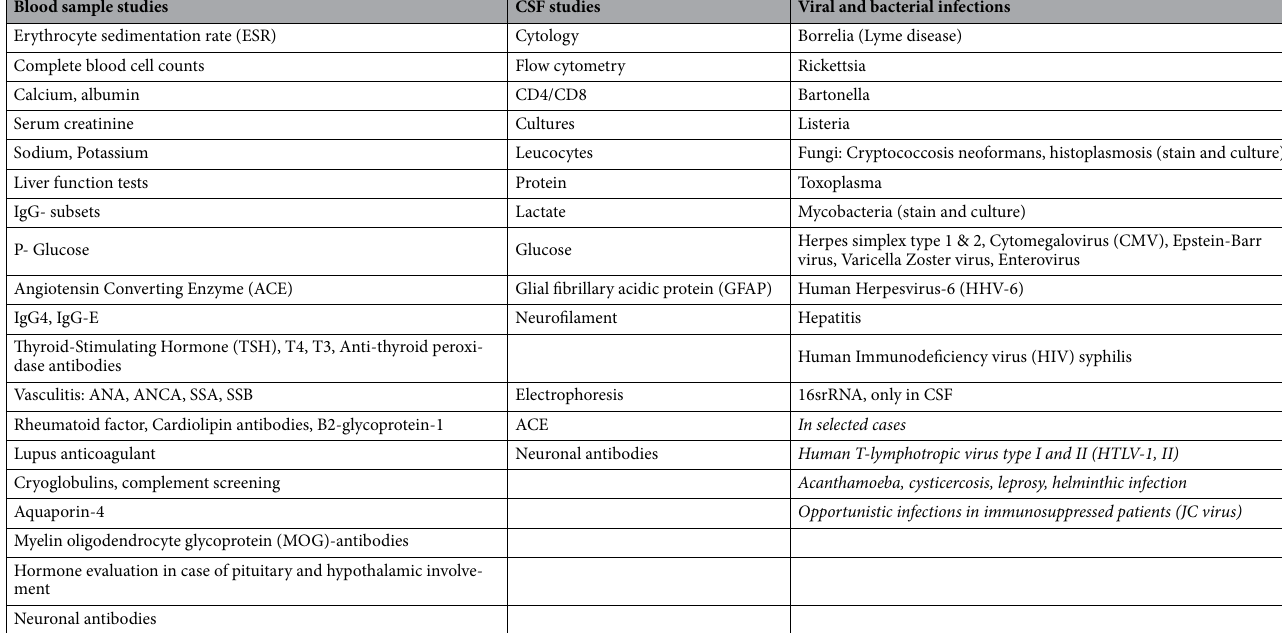
Table 1. The comprehensive laboratory tests for patients with suspected neurosarcoidosis since